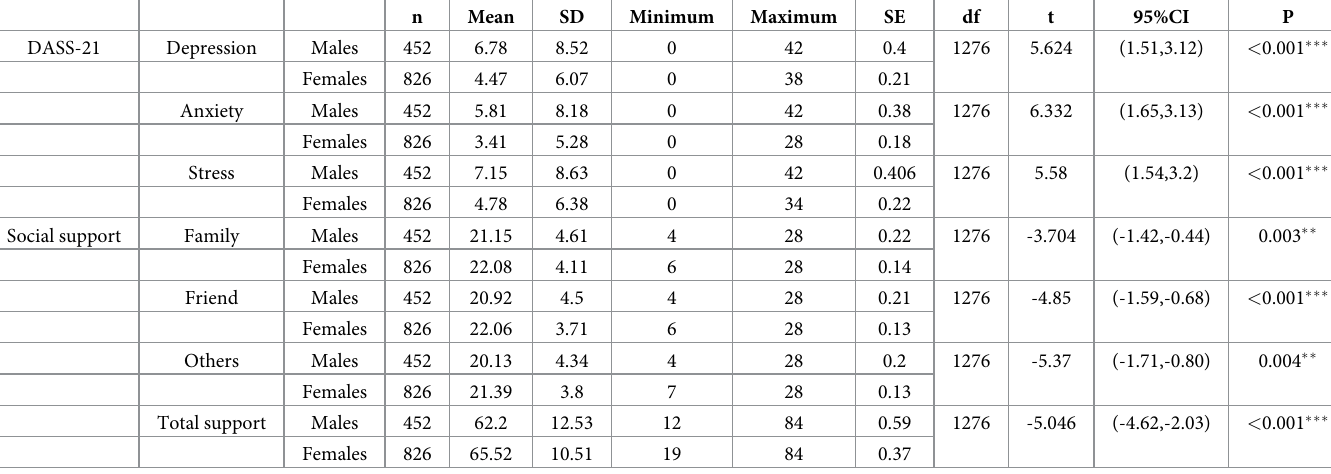
Table 2. Descriptive statistics of each variable by gender and gender differences in each variable.